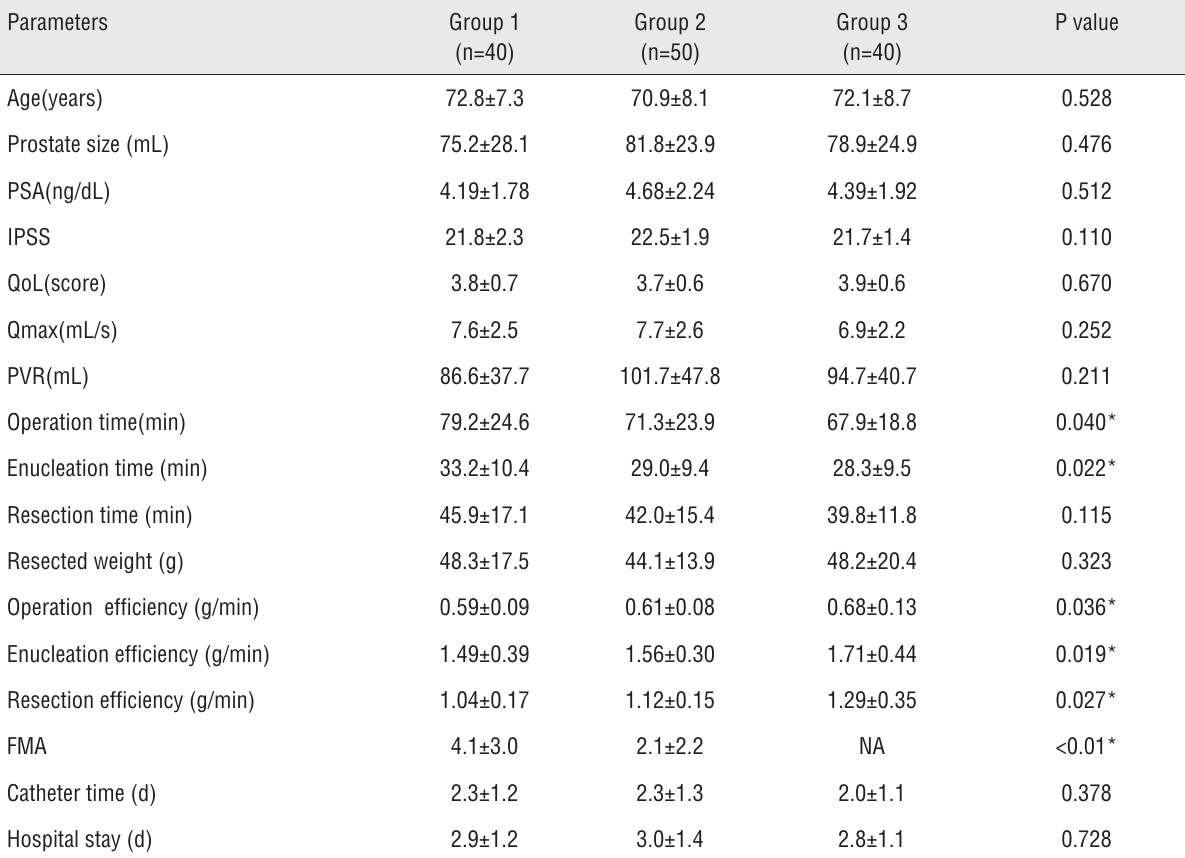
Table 1 - Patients’ demographic and perioperative characteristics.